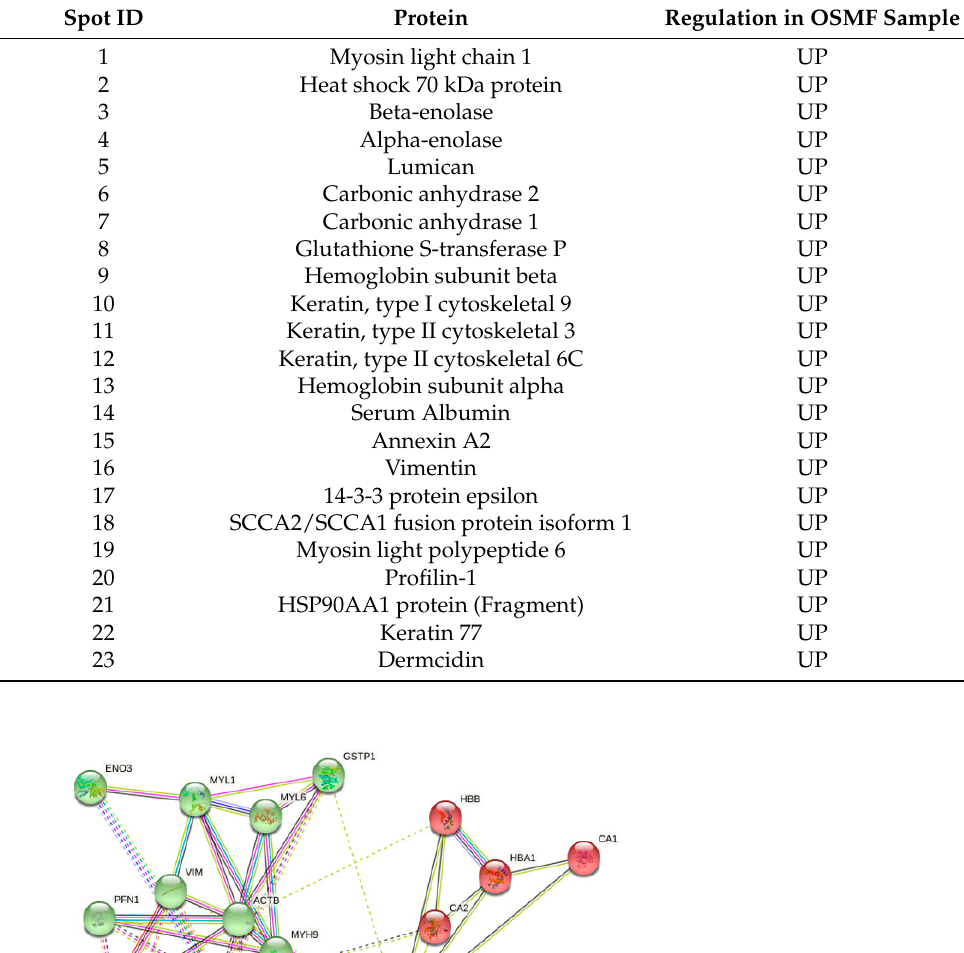
Table 2. List of 23 differentially regulated proteins describing the name and regulation status obtained from Biological Variate analysis.